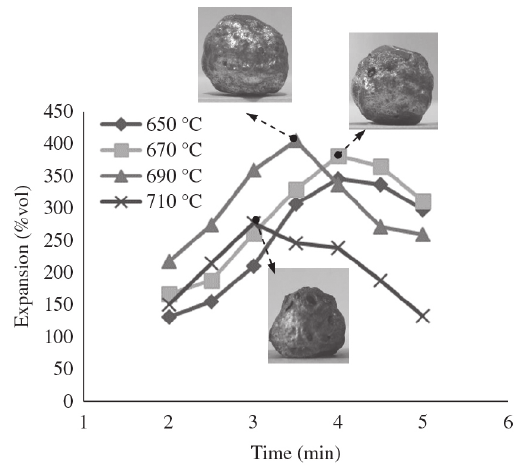
Figure 5. Expansion rates of 50% deformed samples at various foaming temperatures.